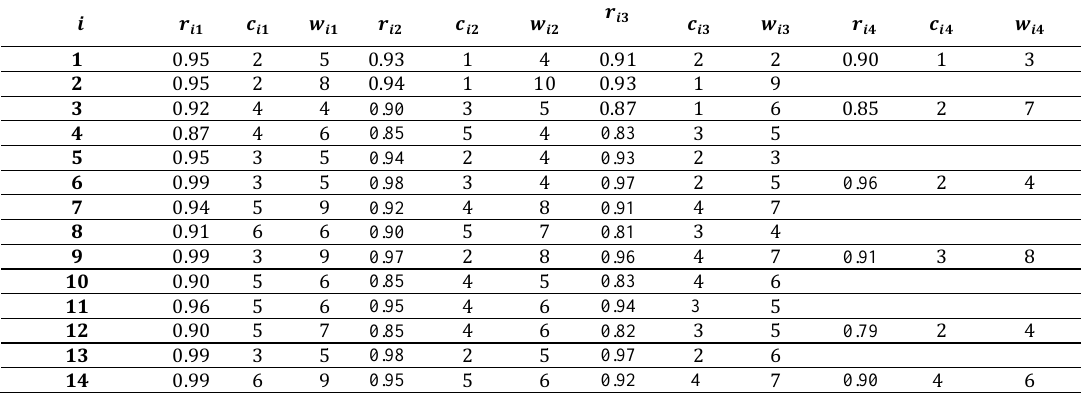
Table 17. Component parameters for testing